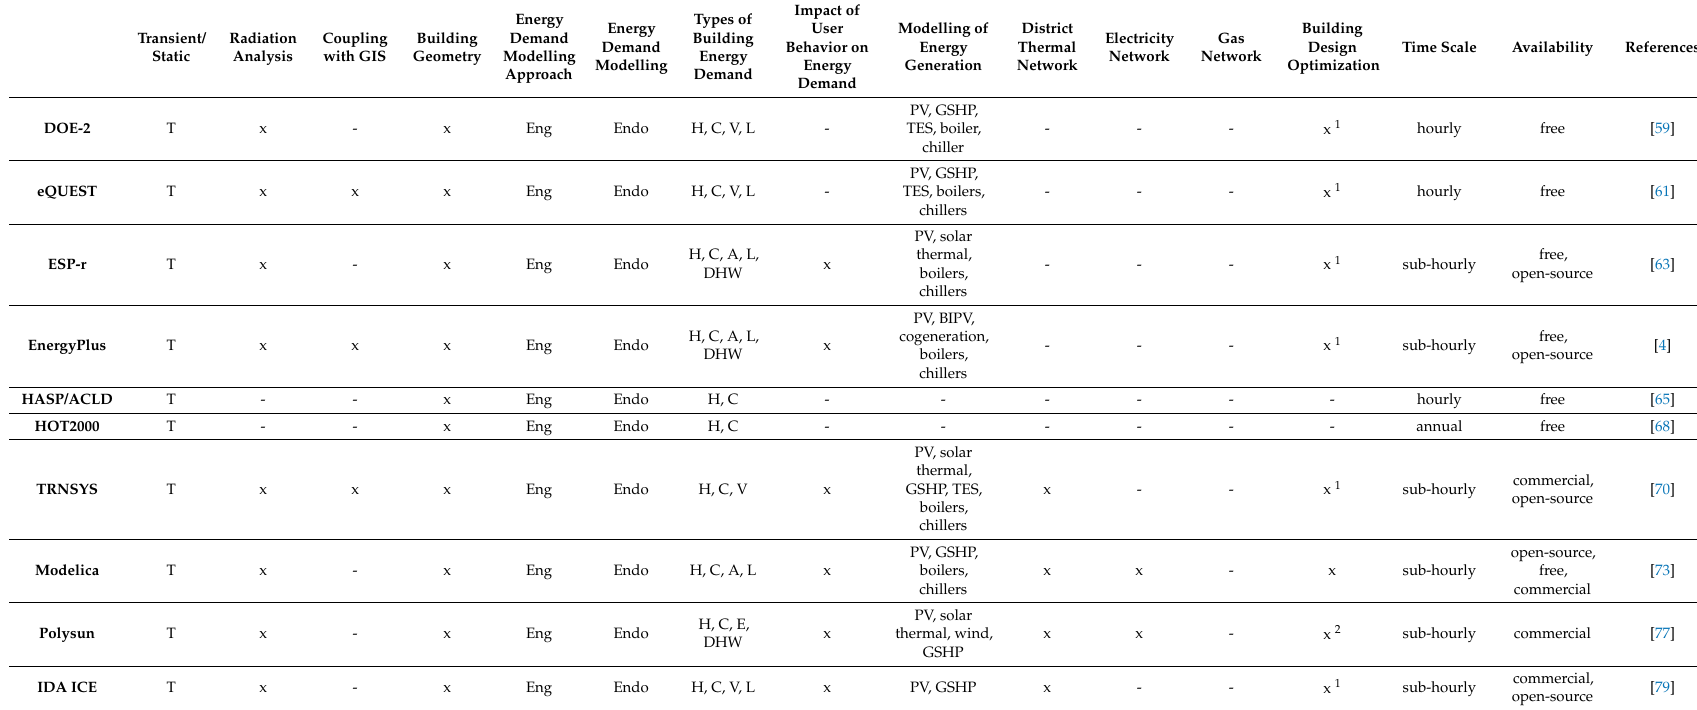
Table 1. Characteristics of reviewed simulation tools for building energy demand in